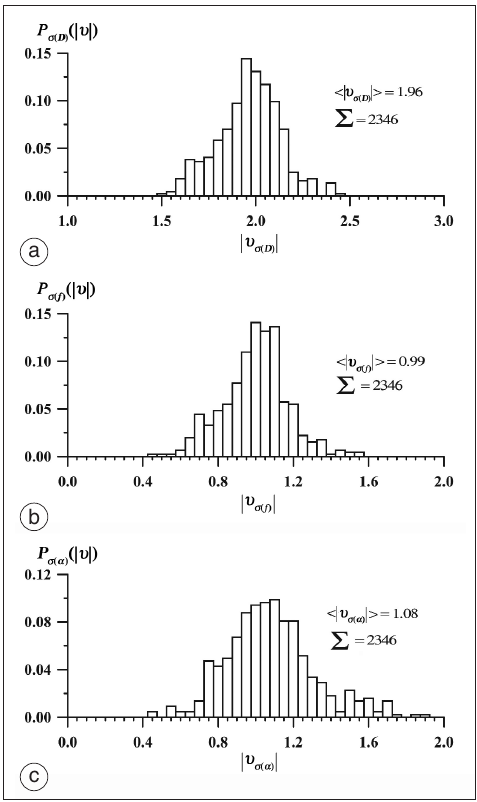
Fig. 8a-c. Probability distributions (a) P σ ( D ) ( ν ), (b) P σ ( f ) ( ν ) and (c) P σ ( α ) ( ν ) of the slopes ν σ ( D ) , ν σ ( f ) and ν σ ( α ) of the power law spectra of the errors and σ ( α ). Mean values of the slopes ν , and also total numbers of the values of the slopes of the correspon- ding spectra use in the analysis are shown in all